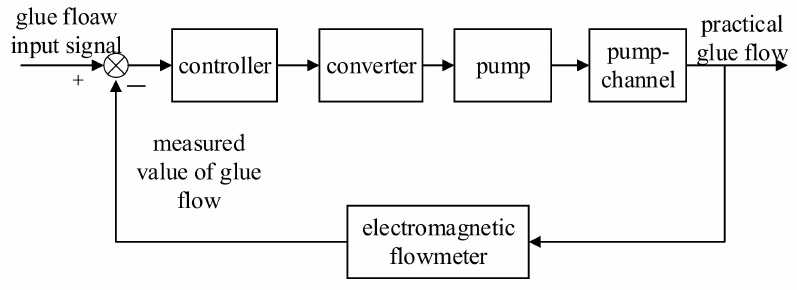
Figure 2. The basic structure of closed-loop control system for glue